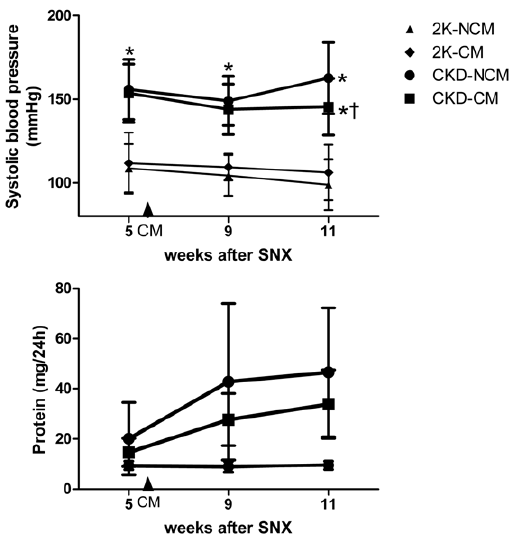
Figure 2. CM treatment decreased systolic blood pressure (A) N and proteinuria (B) in CKD. 2K-NCM (n=6); ¤ 2K-CM (n=6); & CKD-NCM (n=13). *P , 0.05: CKD vs. 2K, { P , 0.05: CKD-CM (n=13); CKD-CM vs. CKD-NCM.